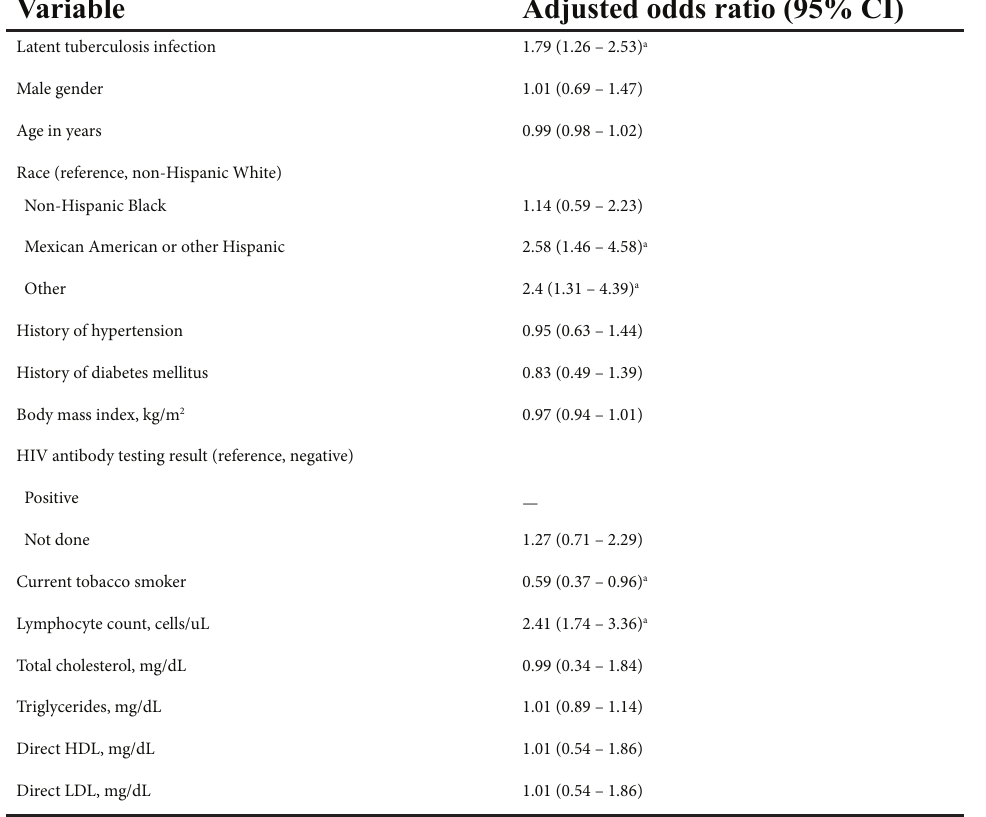
Table 2. Results of ordered logistic regression for interferon-gamma concentration as the dependent